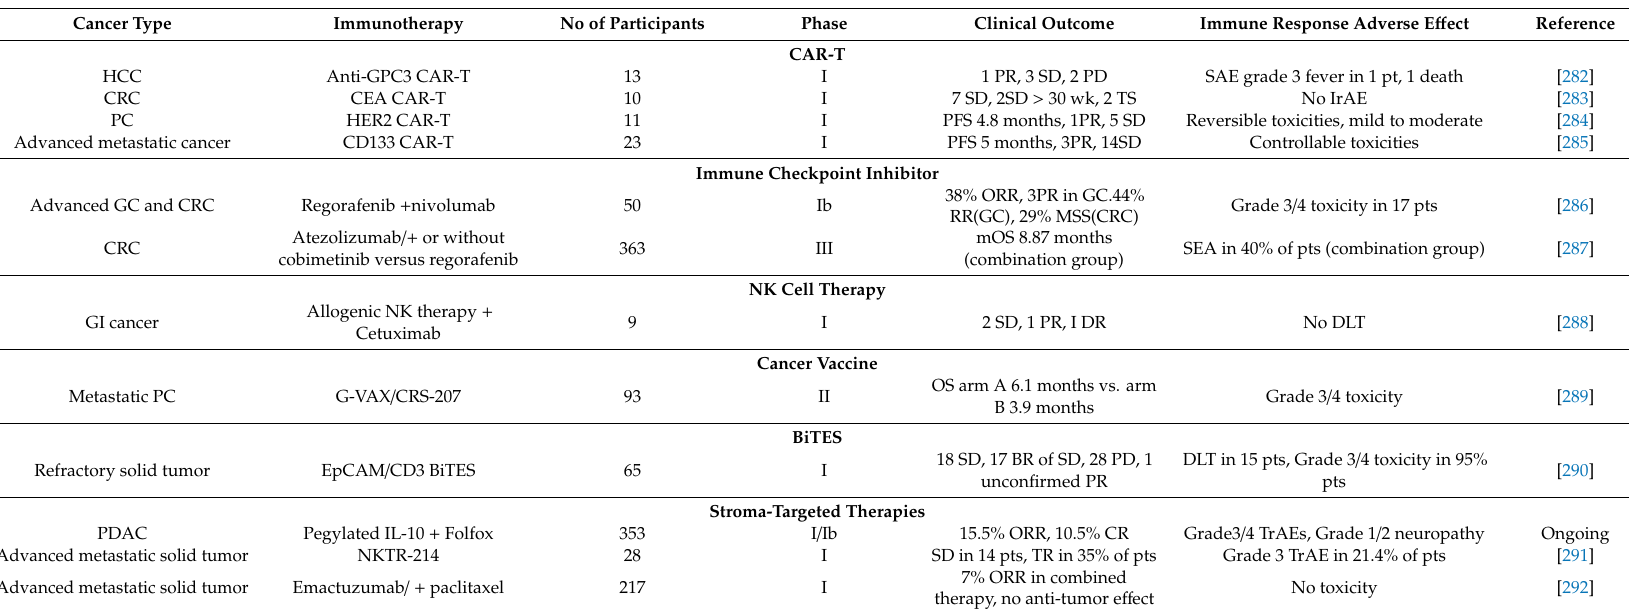
Table 2. Clinical trial e ffi cacy result of selected immunotherapies in GI